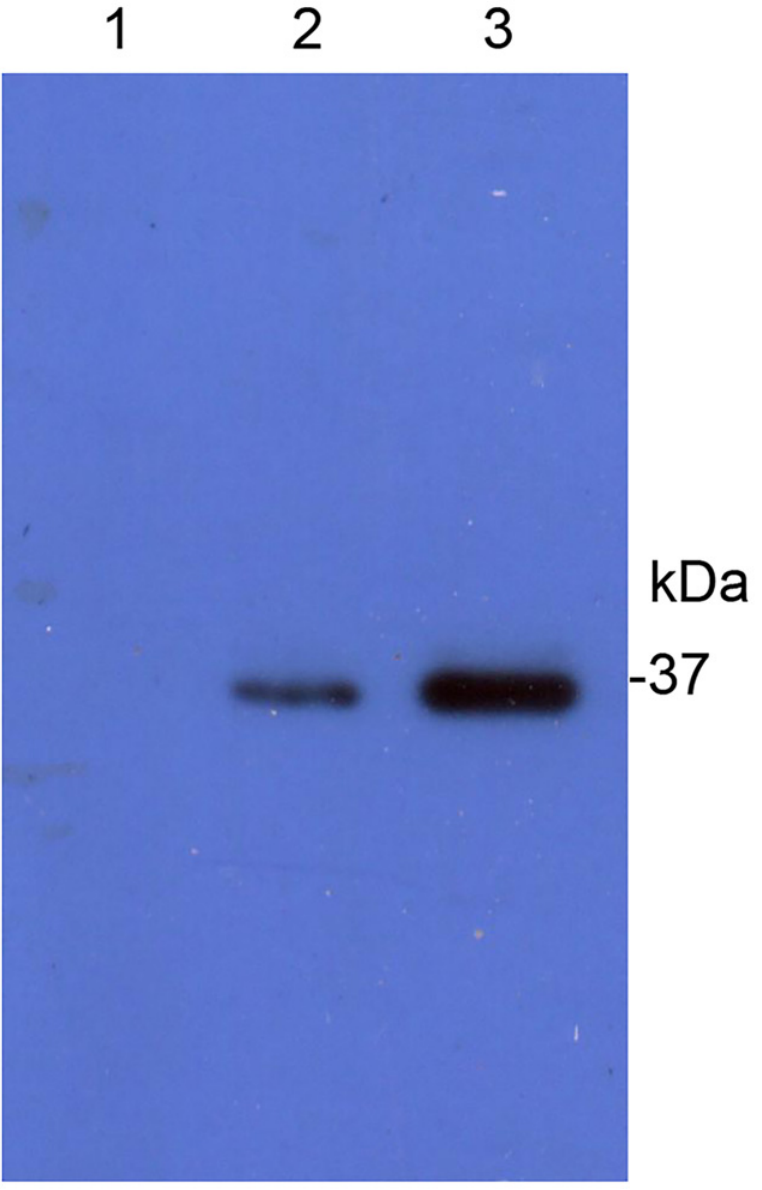
Fig 5. Binding of Cry1Ac to purified ALP fragment (HaALP1f) in ligand blot. The proteins transferred to a PVDF membrane were probed with activated Cry1Ac toxin and detected by a polyclonal anti-Cry1Ac antibody. Lane 1: lysates of E . coli cells transformed with the empty pET28a+ vector; Lane 2: lysates of E . coli cells transformed with HaALP1f-pET28a+ construct, Lane 3: purified HaALP1f from E . coli cells transformed with HaALP1f-pET28a+